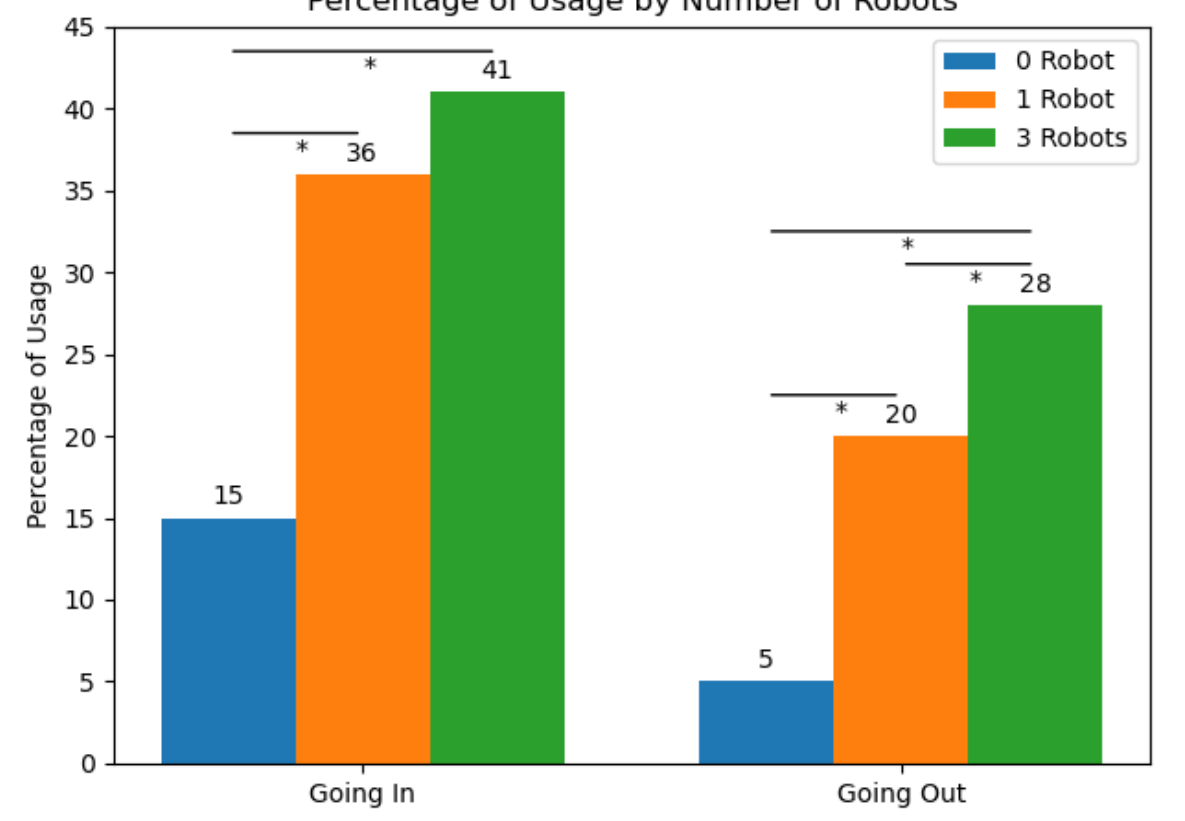
Figure 9. Proportion of participants who used hand sanitizers in the experiment grouped by route taken and configuration of the experiment. * χ 2 test p -value < 0.05 after Holm